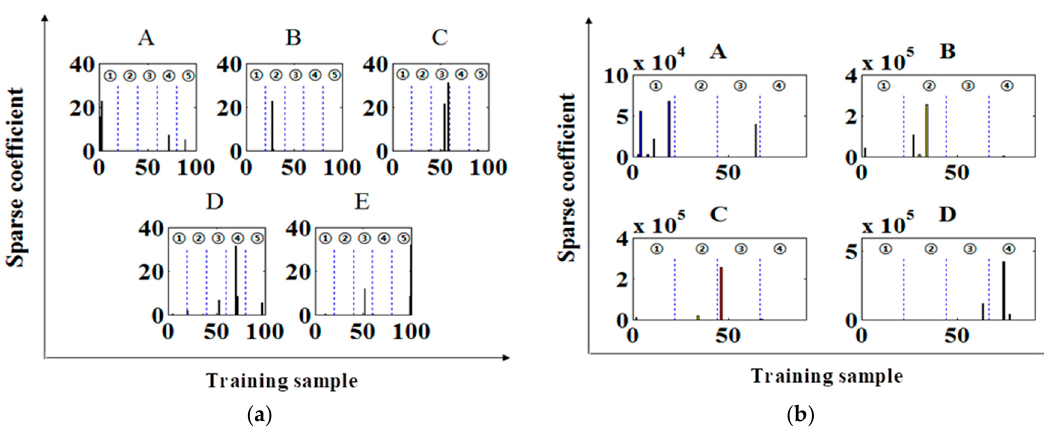
Figure 4. Regression coefficient of the LRSC algorithm. (In each graph, there are a total of 20 samples separated by dashed lines; the numbers above the interval represent different classes; e.g., ① denotes the first class; A, B, C, D, and E stand for the prediction samples that belong to the first through fifth classes, respectively. Symbols ① – ⑤ stand for Pb, Cu, Cd, Zn, and Healthy categories for the infrared spectral data; symbols ① – ④ stand for Cd, Healthy, Pb and Zn categories for the LIBS data, respectively.) ( a ) Infrared spectral data, ( b ) LIBS data.